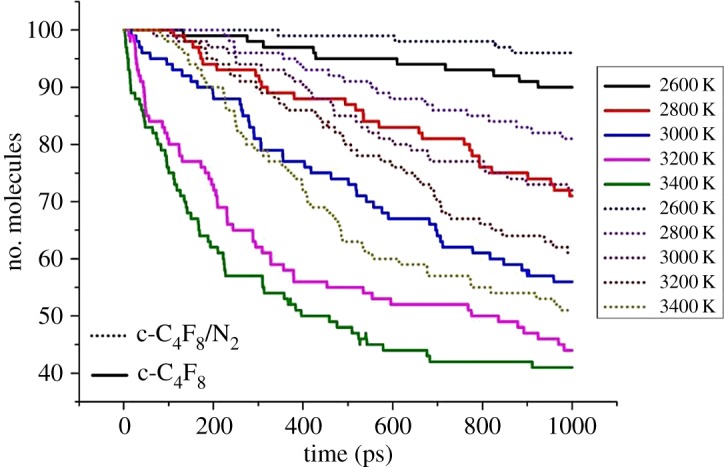
Time evolution of c-C4F8 decomposition at 2600–3400 K.